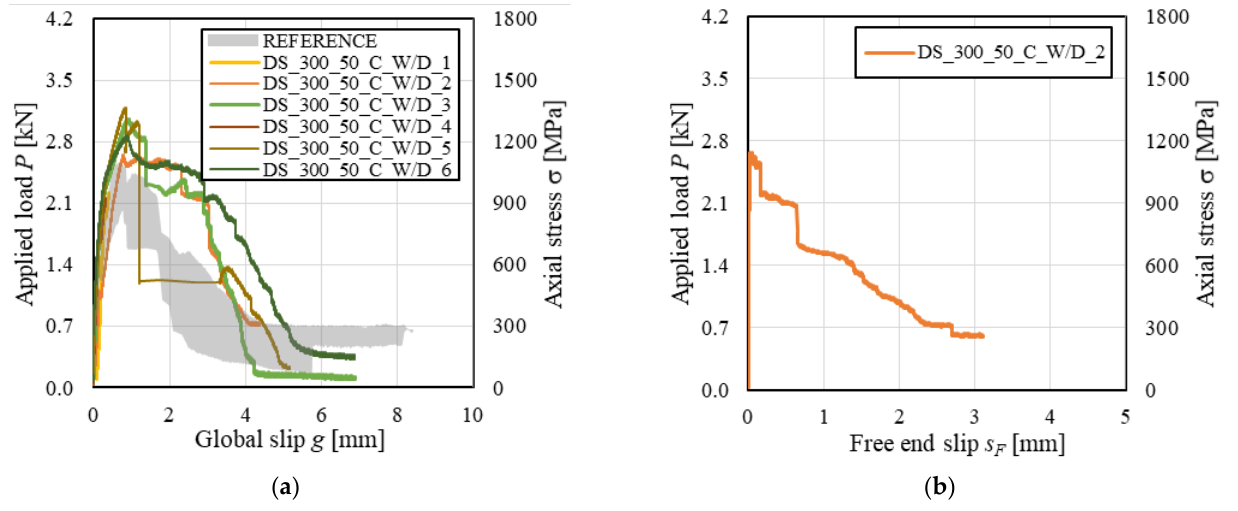
Figure 6. ( a ) P-g and ( b ) P-s F responses of FRCM-masonry joints with carbon fiber textile.